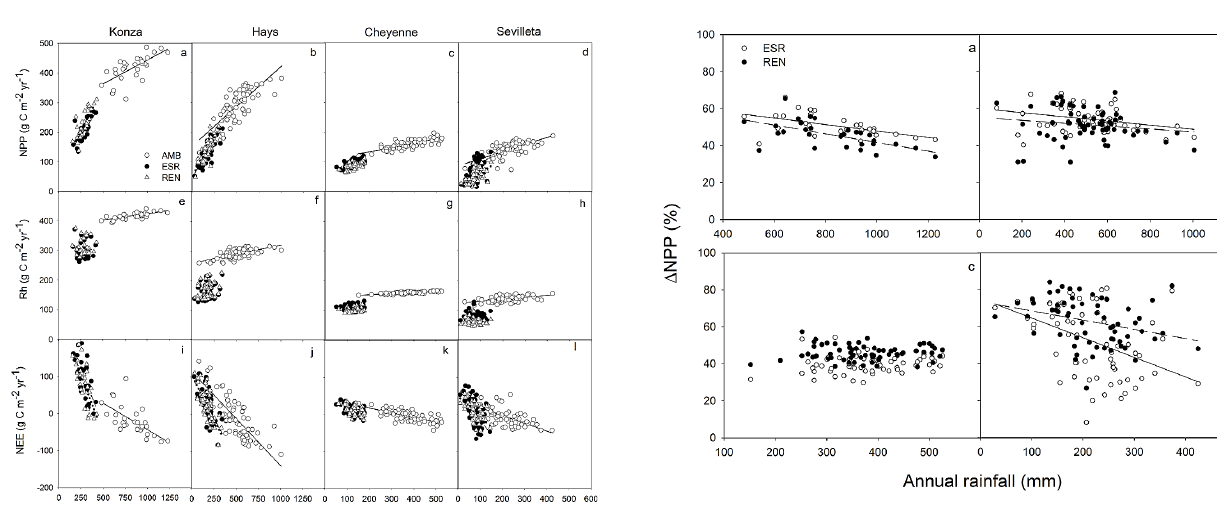
Fig. 5. Relationships between annual rainfall and drought-induced relative reduction in NPP in four North American grasslands (Konza: a ; Hays: b ; Cheyenne: c ; Sevilleta: d ). Open circles rep- resent ESR treatment. Solid circles represent REN treatment. Varia- tion in drought-induced relative reduction in NPP was significantly related to annual precipitation for all but the northern mixed grass site (Cheyenne).